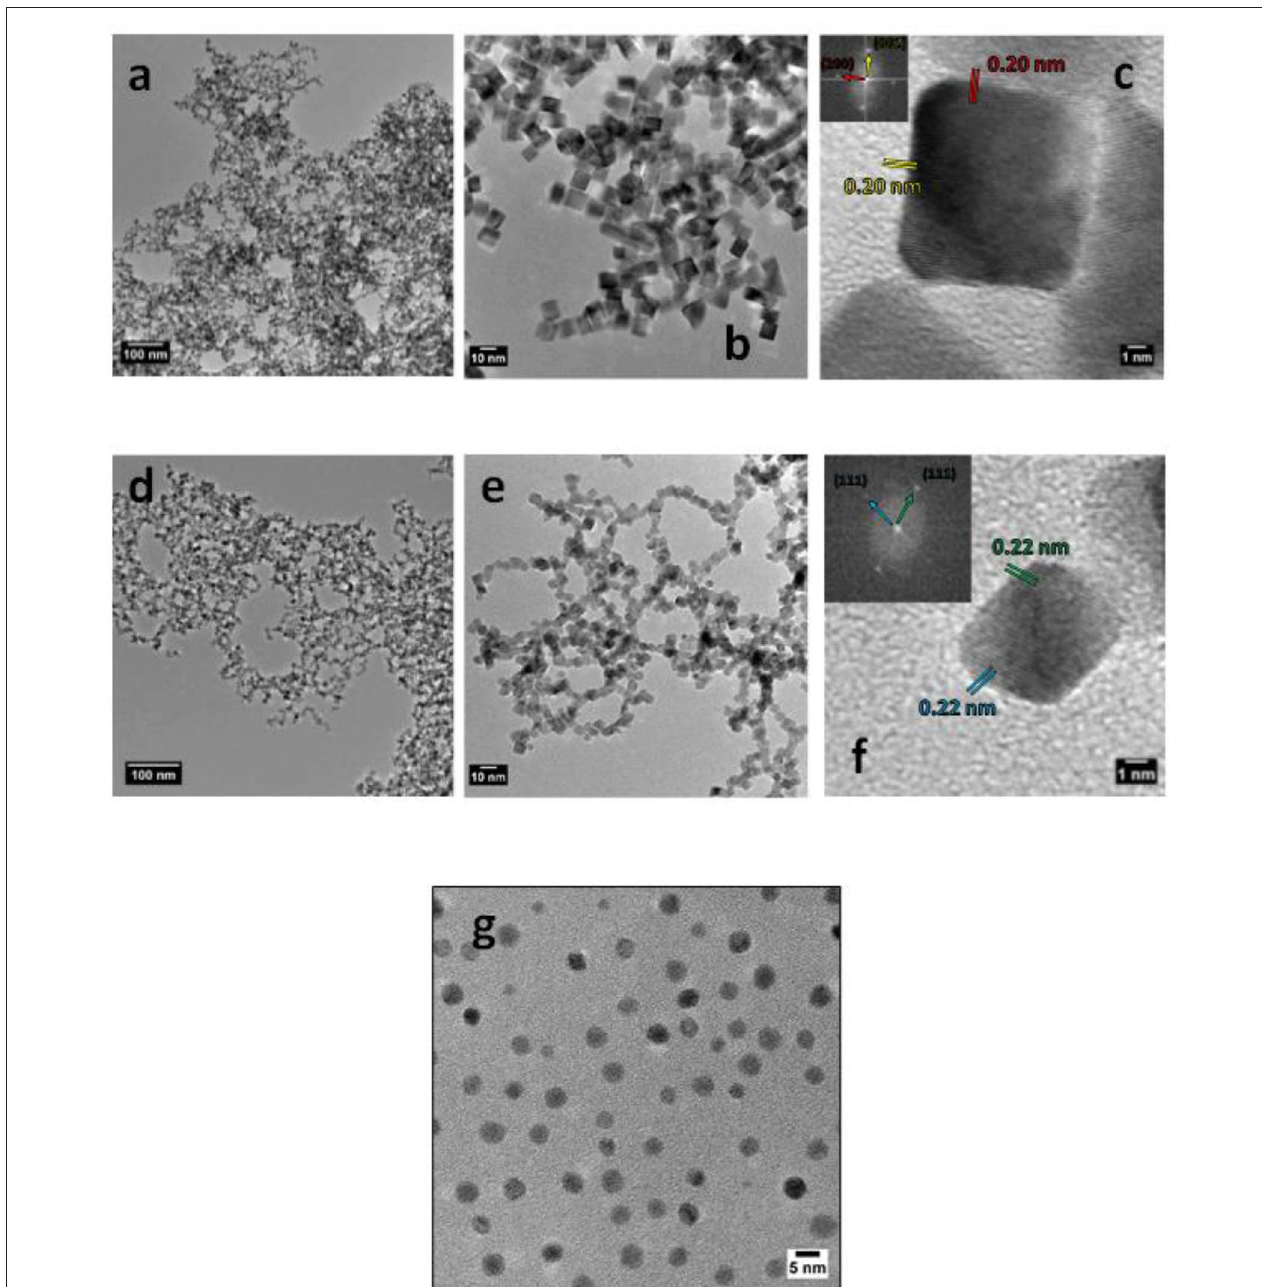
FIGURE 1 | TEM images with different magnifications for (a–c) Pd nanocubes, (d–f) Pd nanooctahedrons, (g) Pd nanospheres. Inset in (c, f) : FFT patterns with corresponding crystallographic orientation, from which d-spacing were determined.